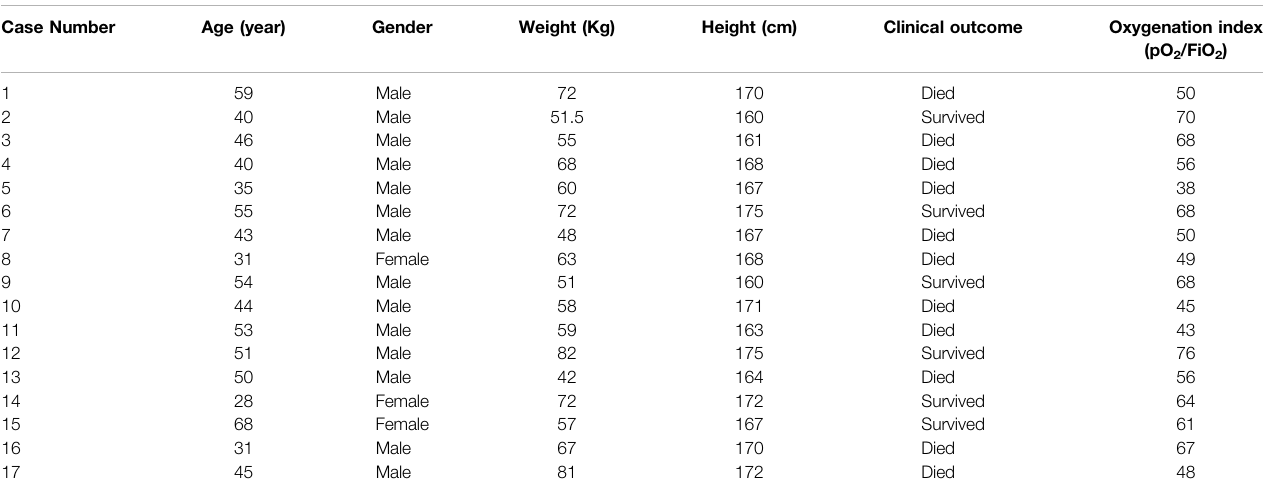
TABLE 1 | The basic clinical features, disease outcome of the control